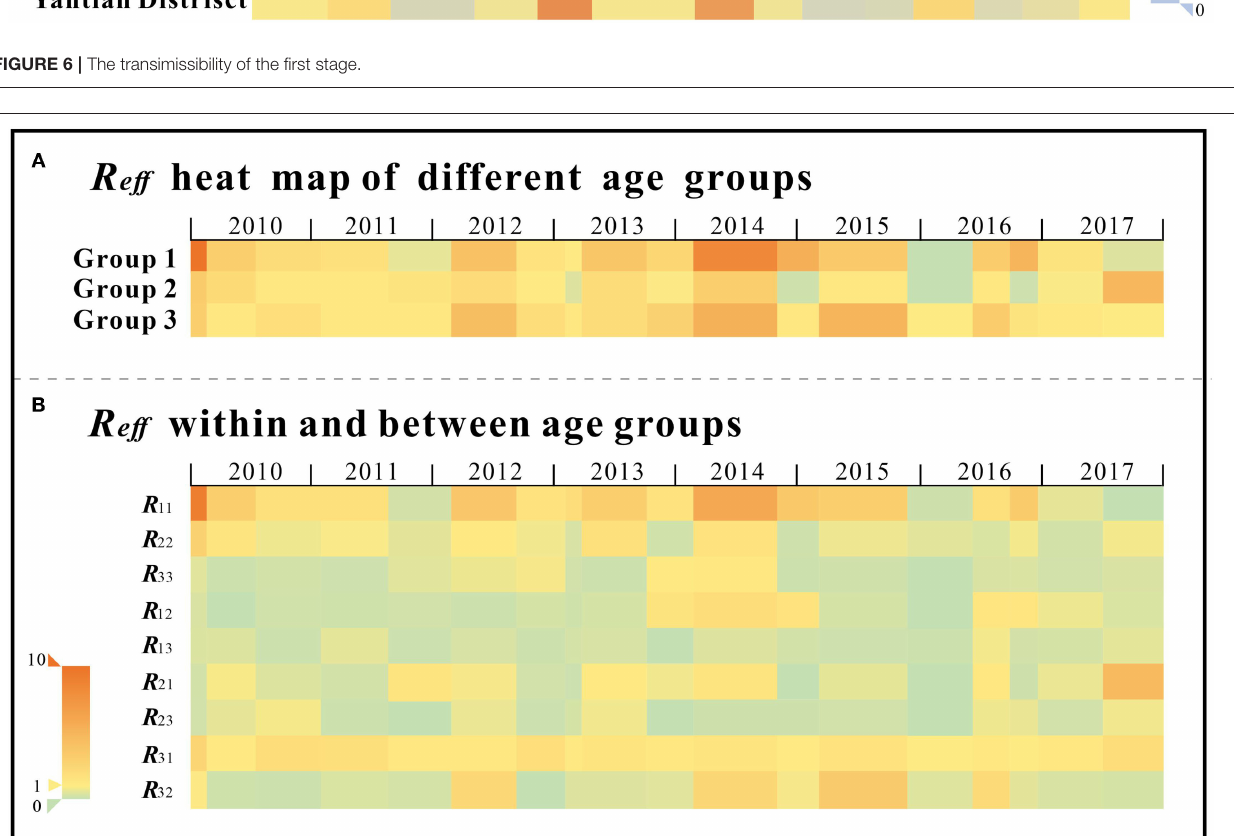
FIGURE 7 | The transimissibility of the second stage (A) Group1 indicates the R eff value of 0–2years old age group; Group 2 indicates the R eff value of 3–5 years old age group; Group 3 indicates the R eff value of over 5 years old age group; (B) Rij denotes the transmission coefficient from individuals in age group i to individuals in age group j , which both i and j take the value 1, 2,